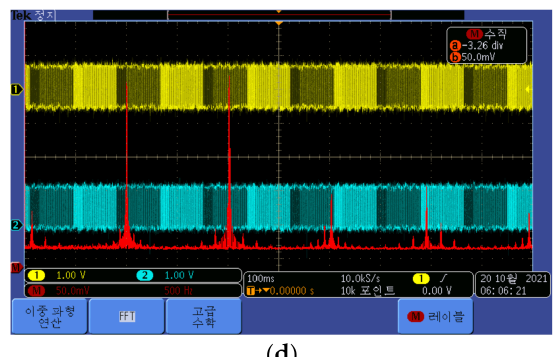
Figure 26. Response characteristics according to the number of PV modules and the operating conditions (low side): ( a ) 1 module and good irradiation; ( b ) 2 modules and good irradiation; ( c ) 3 modules and good irradiation; ( d ) 3 modules and bad irradiation.